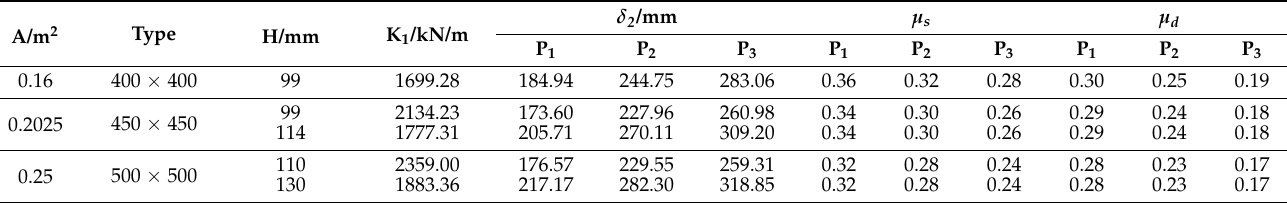
Table 5. LRB constitutive model at steel